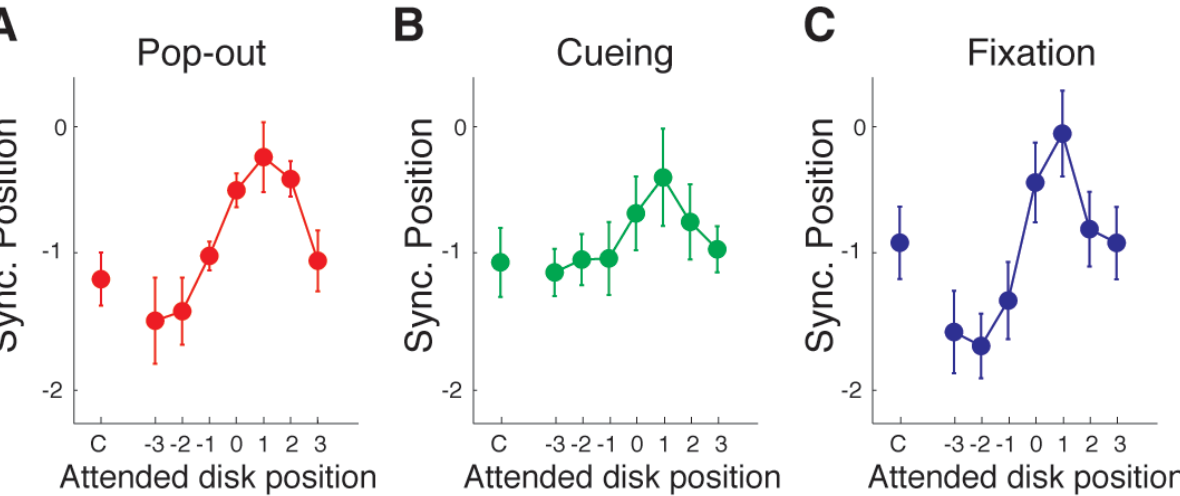
Figure 6. Results of the attentional manipulation experiments. ( A–C ) The mean PSP is plotted as a function of attended position for the pop-out ( A ), cueing ( B ) and fixation ( C ) experiments. The left most data points are the results of the control conditions in which no attentional manipulations were made. In all attentional manipulations, the position of a perceptually sycnhronous disk was most shifted in the forward direction and reached close to the veridical position when observers attended to the disk that occurred one disk later than the veridically synchronous disk. Error bars indicate one s.e.m. (n=6).